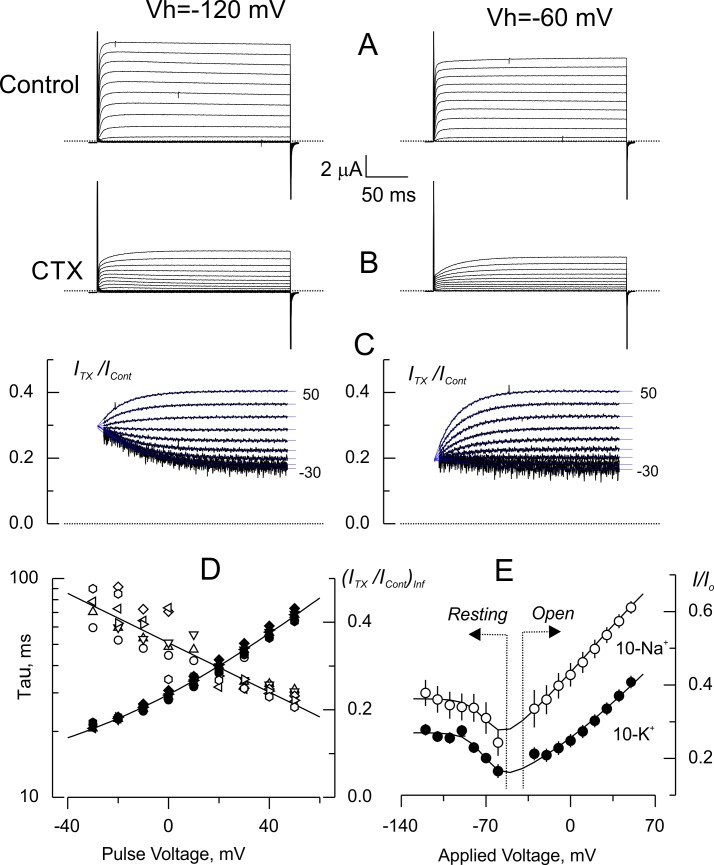
Voltage dependence of tonic CTX inhibition of wild type-Shaker.(A) Representative recordings of potassium currents elicited from holding voltages (Vh) of −120 mV (left) and −60 mV (right) in 10 K+ solution in the same oocyte. The small reduction of currents is probably due to Shaker slow inactivation (González-Pérez et al., 2008). (B). Potassium currents elicited in the presence of 5 nM CTX. Same oocyte and Vh as in A. (C) Point-by-point quotient ratios of traces as in Figure 5. The blue traces are mono-exponential fits to the resulting relaxations within the length of the voltage pulse. Note that the CTX inhibition at resting is different between Vh= −120 and Vh= −60 mV. (D) Fitting parameters of the traces in C. The average time constants (open symbols) and equilibrium inhibition at each voltage (filled symbols) from relaxations elicited from different Vh in the same oocyte (circles: −120 mV; triangles: −120 mV; inverted triangles: −100 mV; diamonds: −90 mV; left rotated triangles: −80 mV; right rotated triangles: −70 mV; hexagons: −60 mV). The continuous lines are polynomial fits with no theoretical meaning. (E). Tonic inhibition as a function of the voltage. Resting indicates measurements made from the resting inhibition at different Vh, while Open specifies the inhibition at equilibrium from the asymptotic values of the voltage dependent relaxations as those shown in C. Each data point corresponds to average of 5 and 6 different oocytes (± SEM) for 10-Na+ and 10-K+ data, respectively. The continuous lines are fits to Equation 5 with the Levenberg-Marquardt method. To fit Equation 5 we used: KDO=KDO(V=0)ezFVRT where z is the toxin effective valence, and Po=11+e-ZF(V-Vo)RT where Z is the effective valence of Kv-channel opening, Vo is the voltage at which Po = 0.5. The rest of the parameters as declared. The fit parameters (± SE) for 10-Na+ were: KDO = 3.9 ± 0.16 nM, z = 0.36 ± 0.03, Vo = −67 ± 7 mV, Z = 4.0 ± 3.1, and KDC = 2.81 ± 0.27 nM; for 10-K+ were: KDO = 1.7 ± 0.05 nM, z = 0.29 ± 0.02, Vo = −66 ± 2 mV, Z = 3.9 ± 0.89 and KDC = 1.84 ± 0.06 nM.